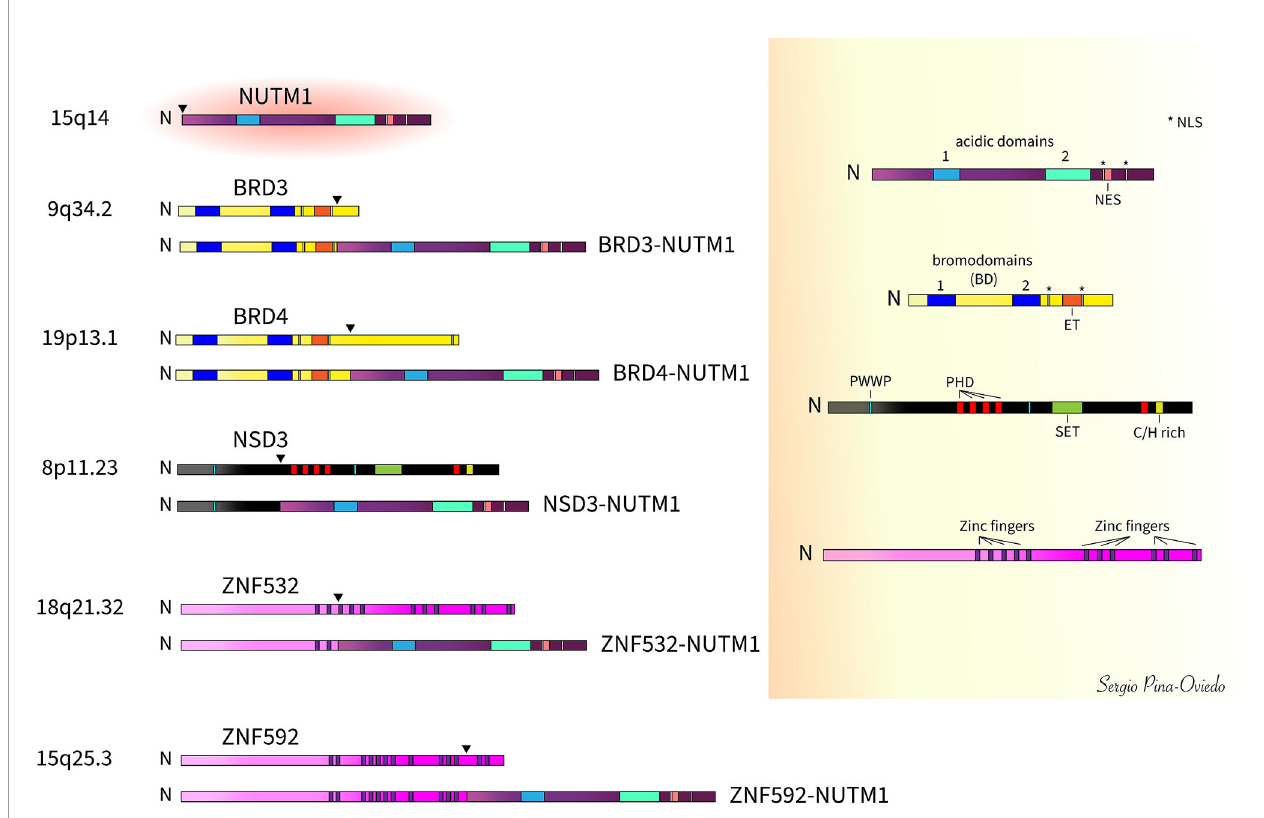
FIGURE 2 | Schematic of NUTM1 fusions with BRD3 , BRD4 , NSD3 , ZNF532 , and ZNF592 and respective wild-type proteins (arrowheads denote fusion breakpoints). The most common of these fusions is BRD4-NUTM1 comprising about 70-80% of all cases. [N, amino- or N-terminal; NLS, nuclear localization signal; NES, nuclear export signal; BD, bromodomains (BD1 and BD2); ET, extra-terminal domain; PWWP, Proline-Tryptophan-Tryptophan-Proline domain; PHD, plant homeo-domain-type zinc- fi nger motifs; SET, Su(var)3-9, Enhancer-of-zeste and Trithorax (SET) domain; C/H rich, SET-associated Cys-His-rich (SAC)